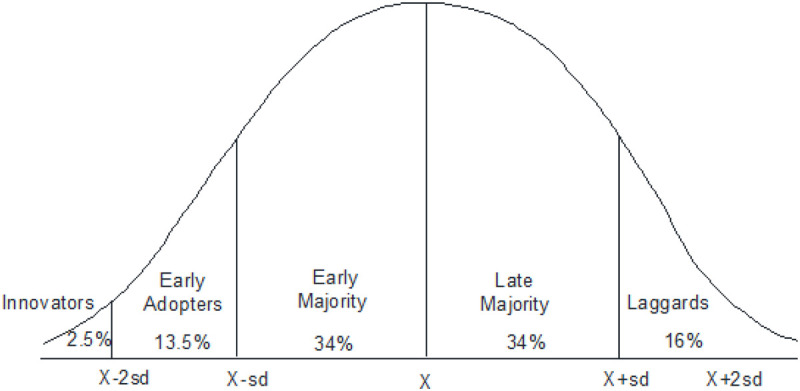
Process of innovation adoption (Rogers, 1983).